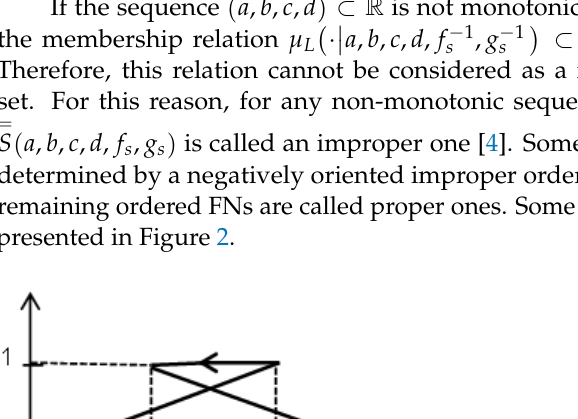
Figure 2. The membership function of ordered FN with: ( a ) A positive orientation, ( b ) a negative orientation.